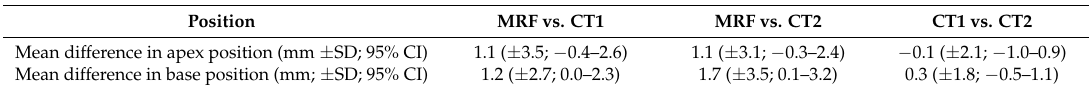
Table 4. Difference in superior-inferior prostate apex and base positions for MR-fusion compared with CT-only